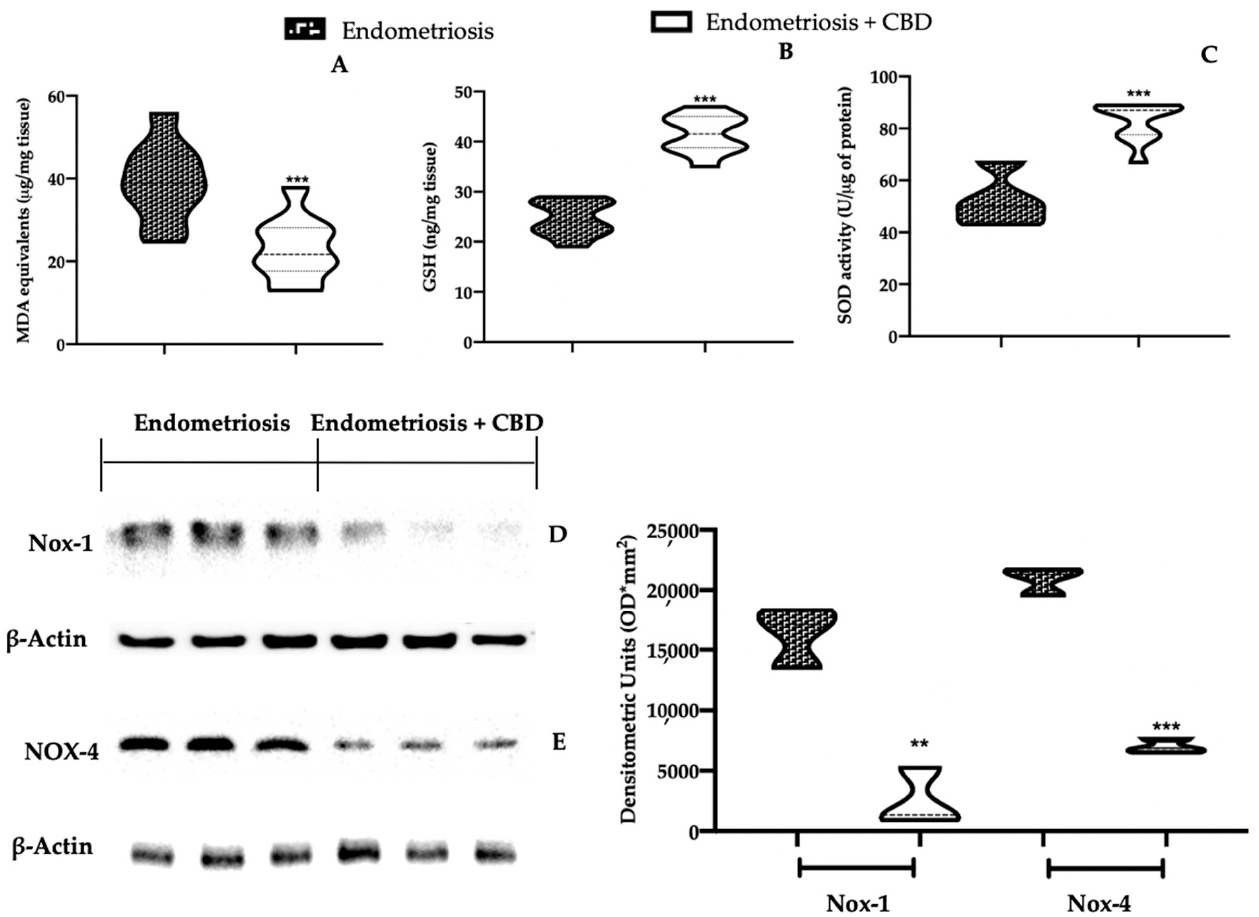
Figure 2. CBD administration reduced pro-oxidative alteration in endometriotic lesions: malondialdehyde (MDA) levels ( A ), GSH levels ( B ), SOD activity ( C ), Western blot analysis of Nox-1 ( D ) and Nox-4 ( E ) expression. For each analysis, n = 5 animals were employed. ** p < 0.01 vs. endometriosis, *** p < 0.001 vs. endometriosis.